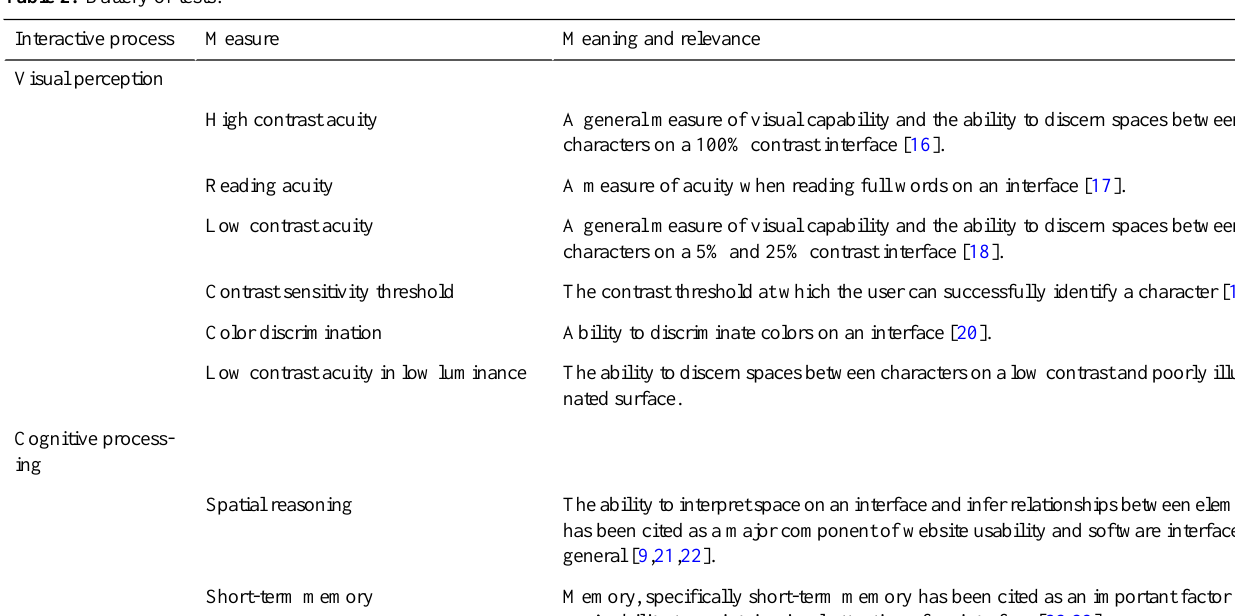
Meaning and relevanceMeasureInteractive process A general measure of visual capability and the ability to discern spaces between characters on a 100% contrast interface A measure of acuity when reading full words on an interface [17].Reading acuity A general measure of visual capability and the ability to discern spaces between characters on a 5% and 25% contrast interface The contrast threshold at which the user can successfully identify a character [19].Contrast sensitivity threshold Ability to discriminate colors on an interface [20].Color discrimination The ability to discern spaces between characters on a low contrast and poorly illumi- nated